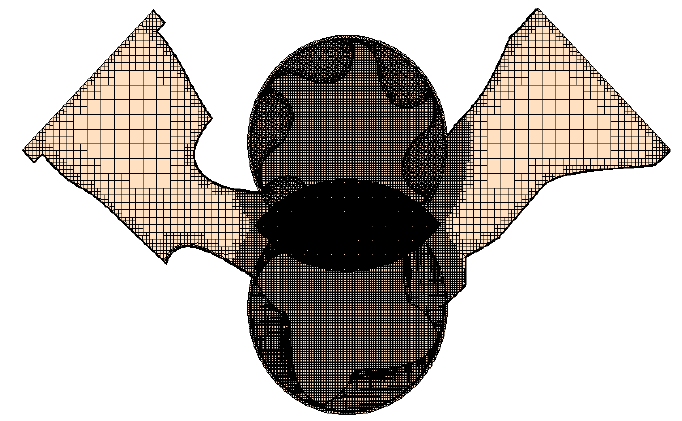
Figure 6 . The grid section created by the hole cutting process in this study.